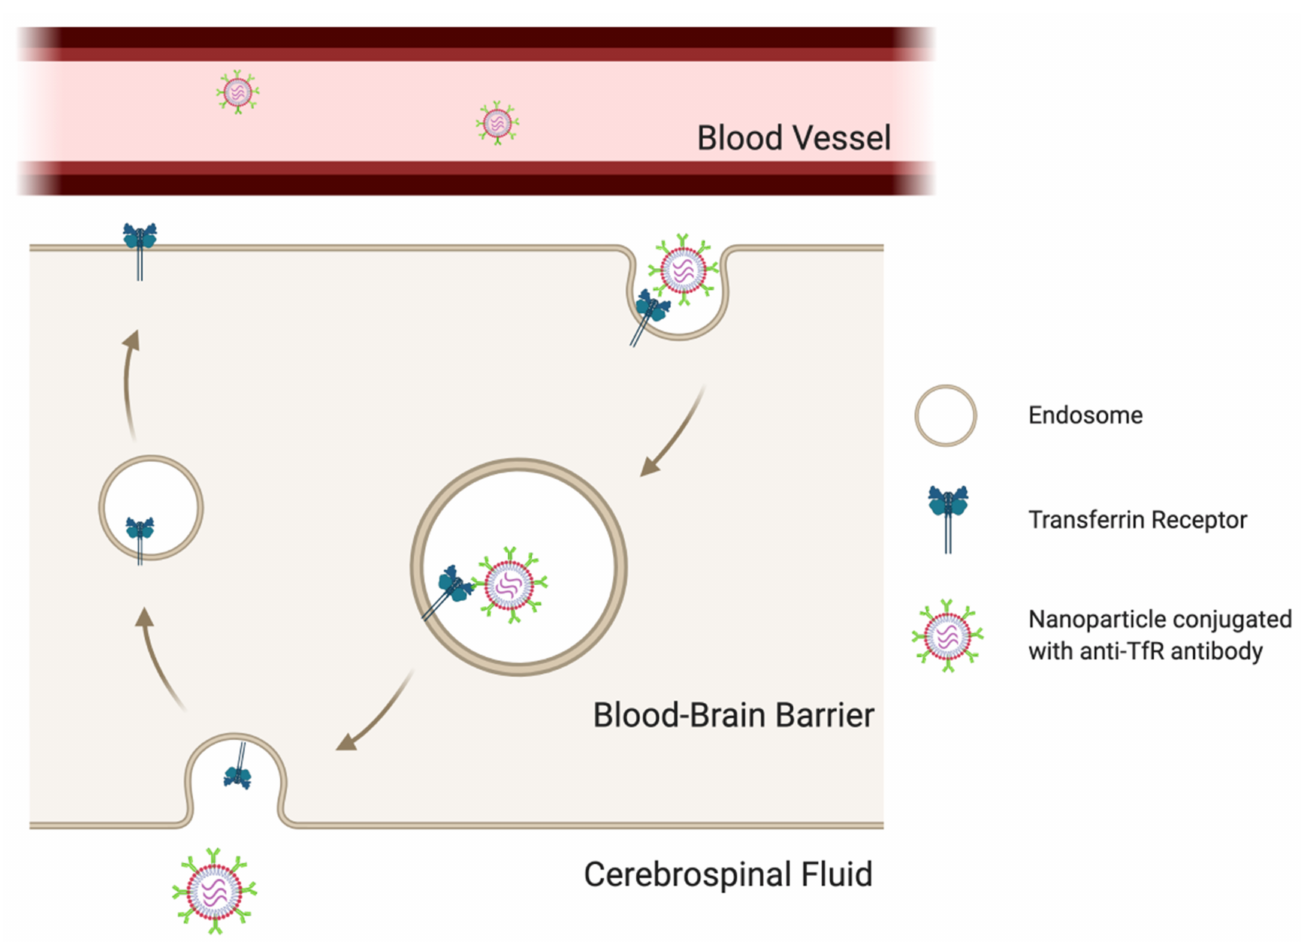
Figure 2. Transferrin receptor (TfR)-mediated transcytosis across the blood–brain barrier (BBB). The transcytosis is initiated by the binding of anti-TfR antibody conjugated on the surface of nanoparticles with the formation of endosome. Nanoparti- cles are transported to the brain side by membrane fusion. TfRs are then recycled to the original side also by the transport of endosome. (Created with BioRender.com at 6 March